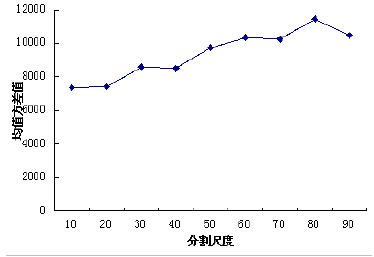
Figure 1. Relationship between segmentation scales and mean-variance